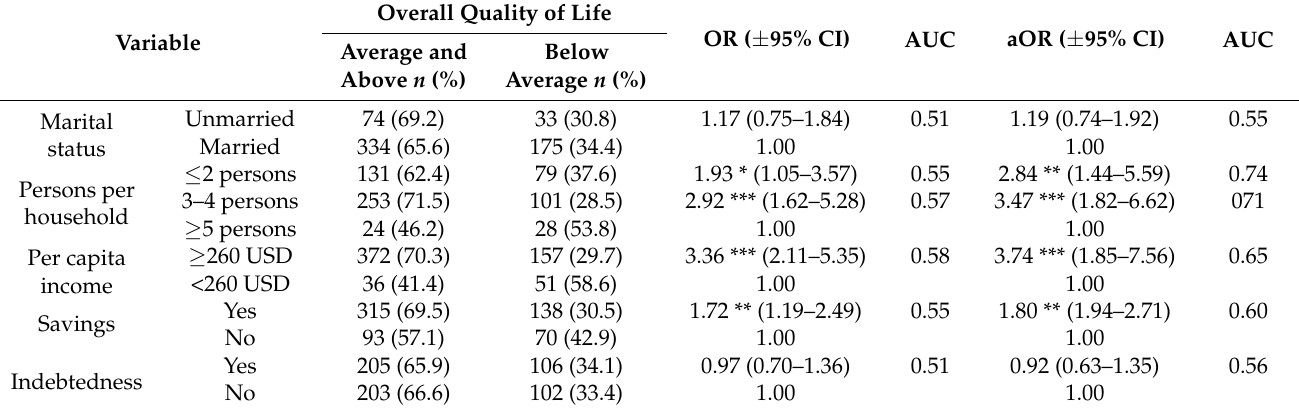
Table 3. Overall quality of life and socioeconomic status of private entrepreneurs from Wrocław ( N = 616).